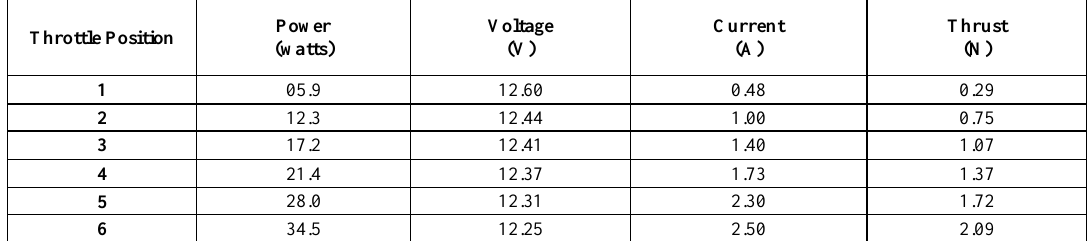
Table 4. Tabulation of forward thrust for different throttle positions